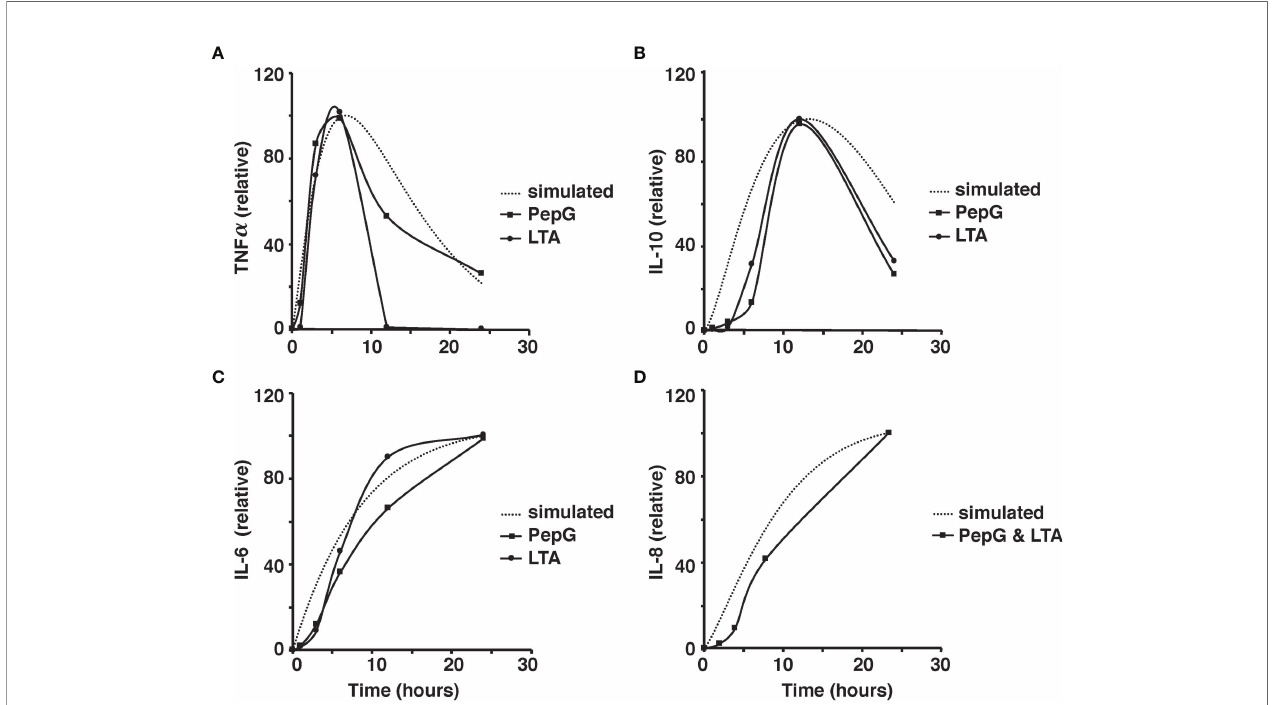
FIGURE 4 | Comparison of the simulated TNF- ⍺ and experimental TNF- ⍺ activity in response to the introduction of 10 m g of PepG/mL or 100 m g of LTA/mL of human blood over the 24-hour period (A) . Comparison of the simulated IL-6 and experimental IL-6 activity based on the introduction of 10 m g of PepG/mL or 100 m g of LTA/mL of human blood over a 24-hour period (B) . Comparison of the simulated IL-10 and experimental IL-10 activity based on the introduction of 10 microgram of PepG/mL or 100 m g of LTA/mL of human blood over the 24-hour period (C) . Comparison of the simulated IL-8 and experimental IL-8 activity based on the introduction of S. aureus -infected endothelial cells containing 10 m g of PepG/mL and 100 m g of LTA/mL over the 24-hour period (D) . All cytokine concentrations are relative values as discussed in the methods.